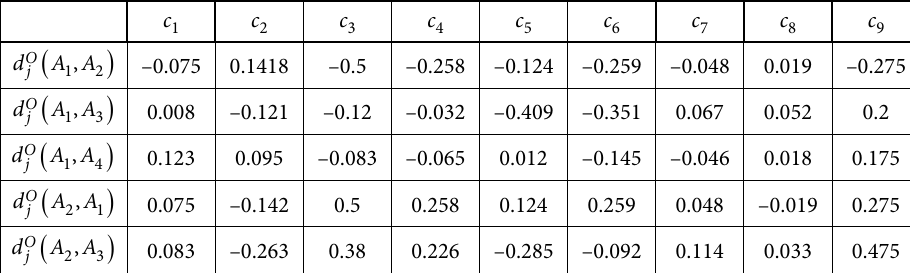
Table 3. Objective deviations among alternatives over each